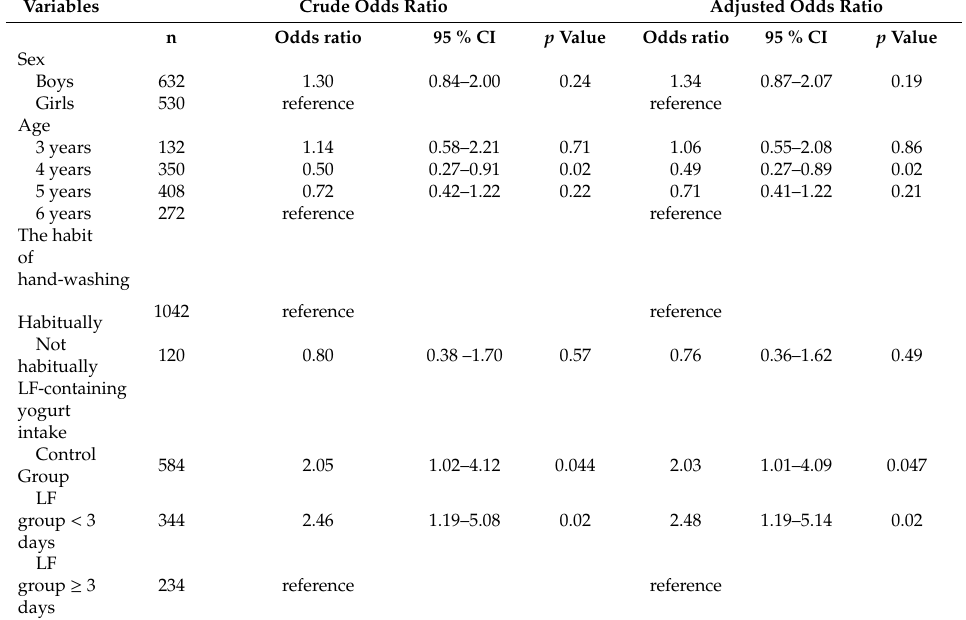
Table 4. Relationships of the absence due to vomiting and LF-containing yogurt intake, by the logistic regression